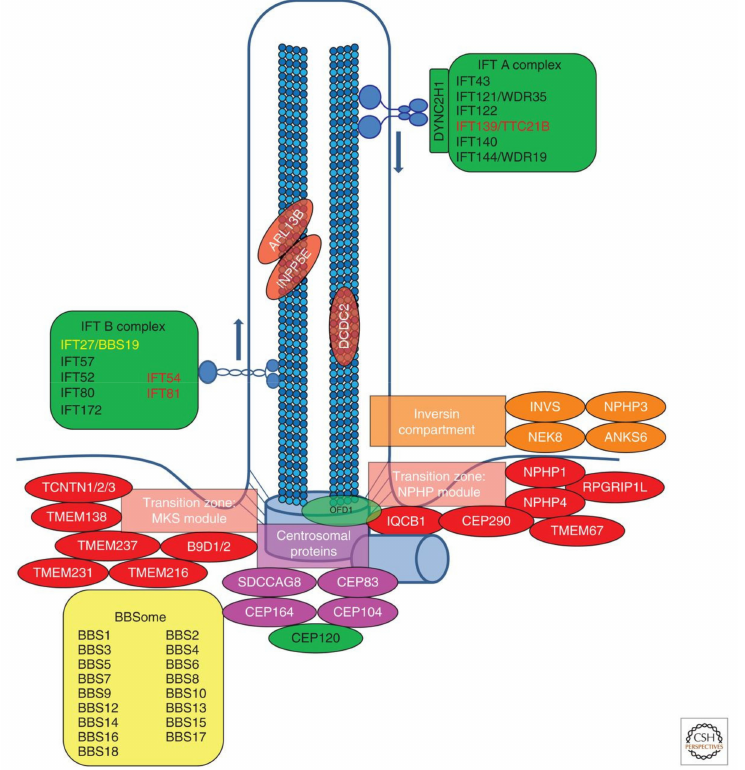
Figure 2. Subcellular localization of protein encoded by monogenic genes of nephronophthisis-related cilioipathies (NPHP-RC). Subcellular localization of proteins encoded by monogenic genes of NPHP- RC is depicted. Proteins are color-coded based on their respective disease group: Nephronphthisis (NPHP), Senior–Loken syndrome (SLS), Joubert syndrome (JBTS), Meckel–Gruber syndrome (MKS), Bardet–Biedl syndrome (BBS), and skeletal ciliopathies. It becomes apparent that disease groups cluster to distinct subcellular localizations. IFT, intraflagellar transport. Reproduced from [5], with